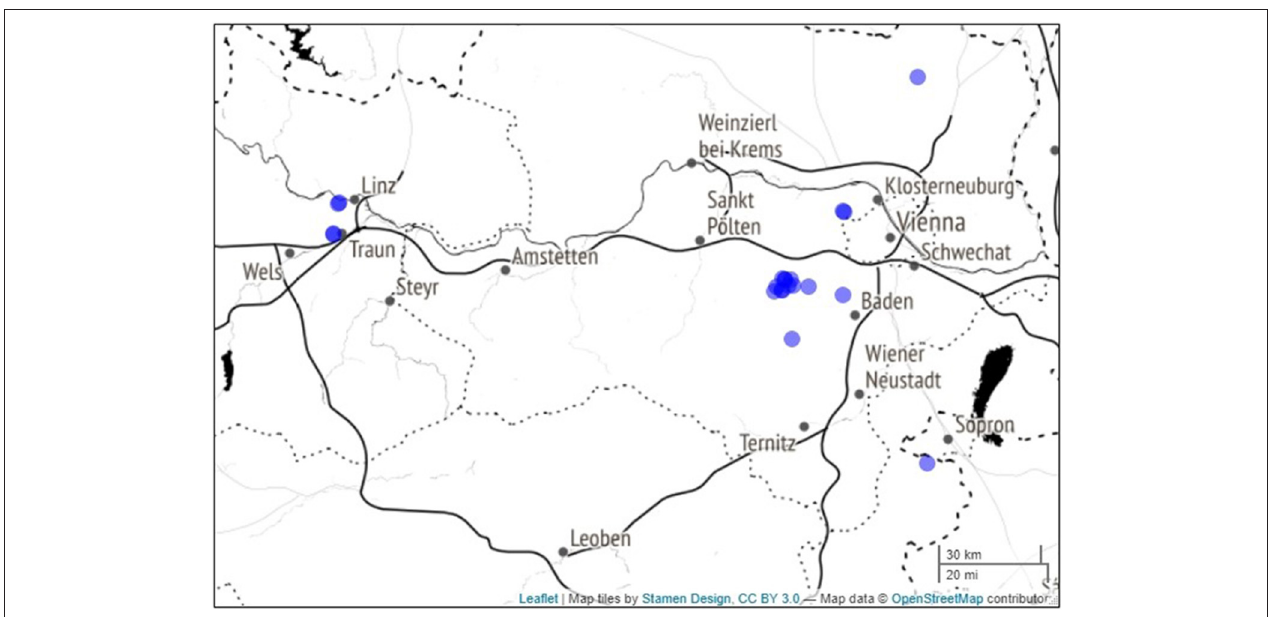
FIGURE 1 | Map of the 21 testing sites (blue dots) spread accross North-Eastern Austria. A darker blue color means that sites are overlaping at this scale.